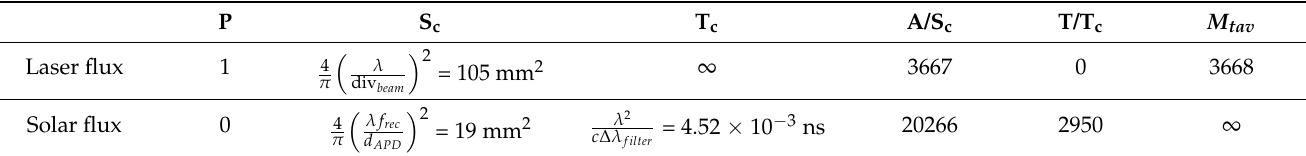
Table 3. Polarisation index, characteristic area and characteristic time involved in the calculation of M tav the speckle number for the laser and solar fluxes. λ is the wavelength, div beam = 181.25 µ rad the full divergence of the laser beam at the output of the transmitting telescope measured at the e − 2 energy level, f rec = 47.04 cm the focal length of the receiving chain, d APD = 0.2 mm the diameter of the detector and ∆ λ filter = 2 nm the filter bandpass. P S c T c A/S c T/T c M tav Laser